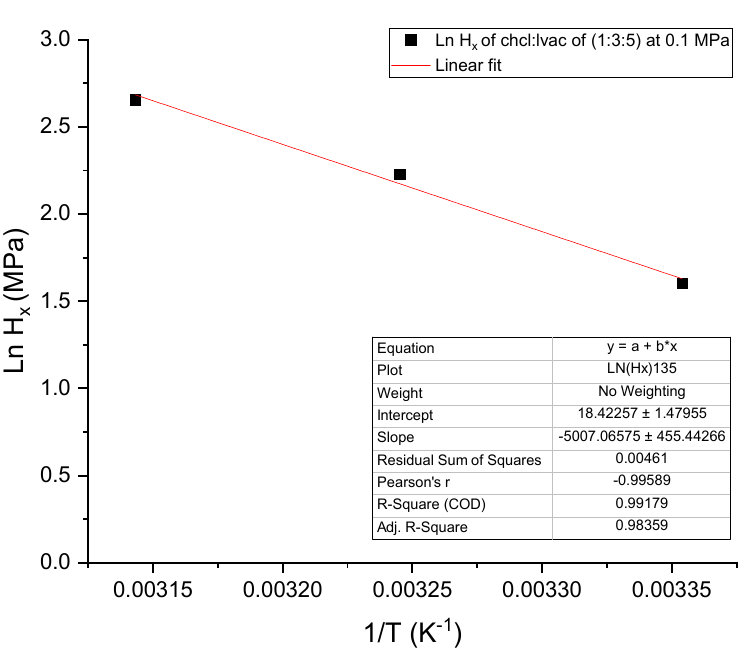
Figure 4. Arrhenius plot of Henry’s law constant for the absorption of CO 2 in ChCl:LvAc (1:3:5). 3.3. The Effect of Stirring Speed on the CO 2 Absorption Capacity of the DES The CO 2 absorption capacity of ChCl:LvAc (1:2:0) mole at 25 °C increases steadily with stirring speed as shown in Figure 5. The raw data are available in Table S3 in the supplementary information document.